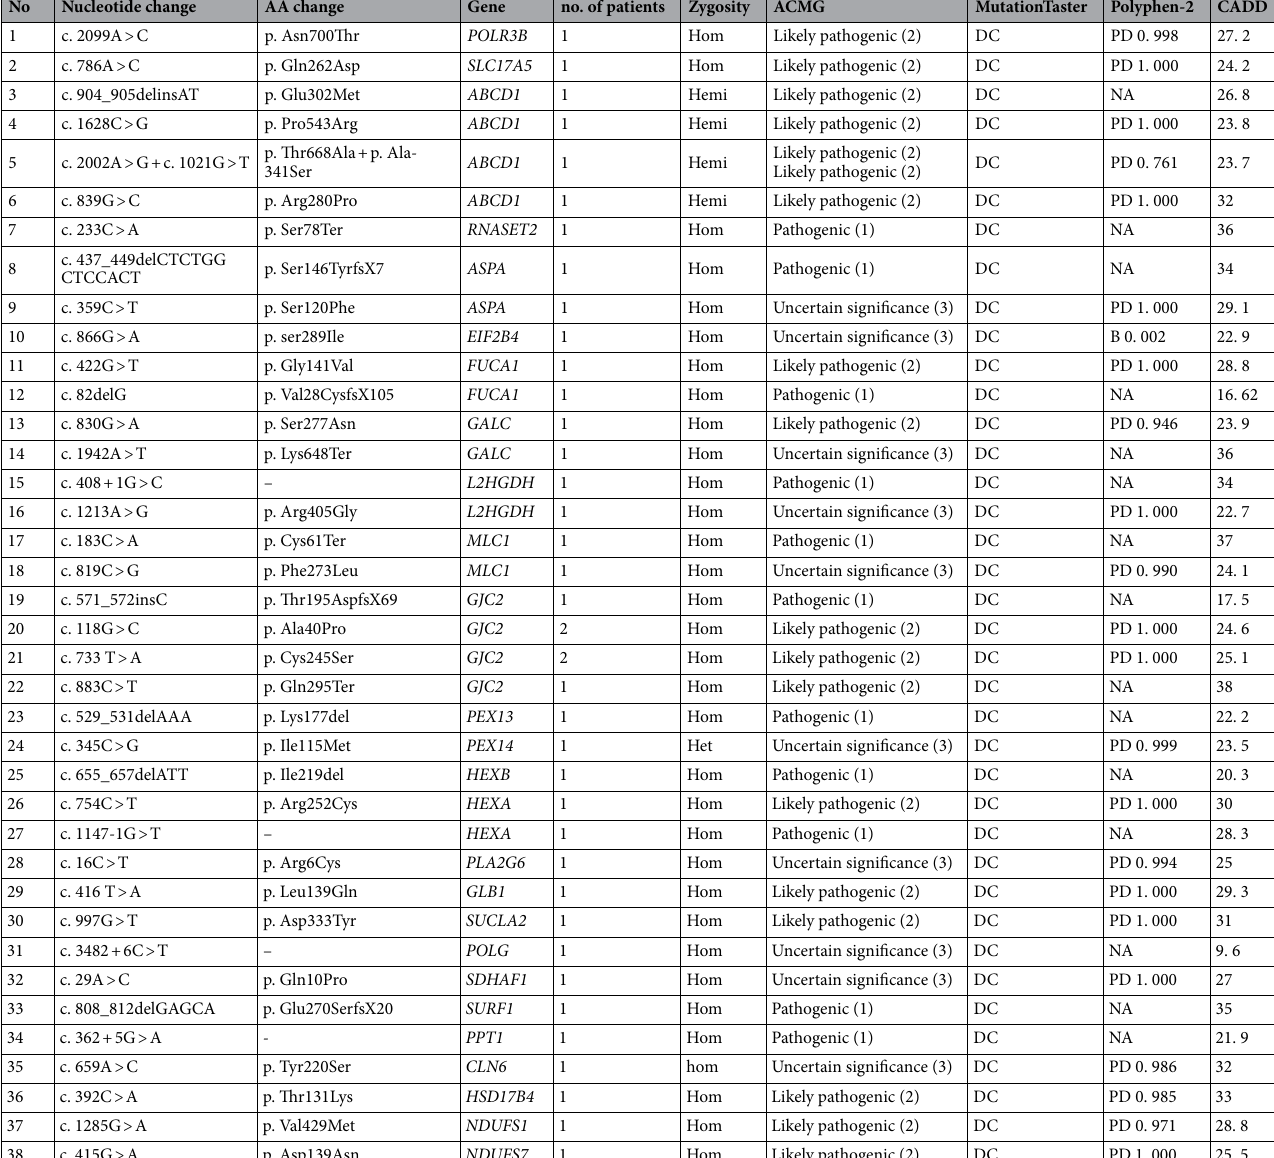
Table 2. Novel variants identified in this study. DC: disease causing, PD: probably damaging, Hom = homozygous, B = benign, NA = not